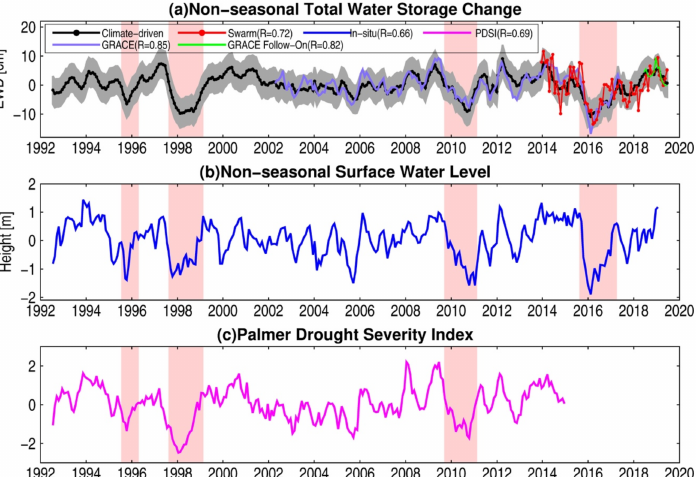
Figure 5. ( a ) Nonseasonal signals of the climate-driven, GRACE, GFO, and Swarm TWSC, ( b ) non- seasonal surface water level, and ( c ) basin-averaged Palmer Drought Severity Index (PDSI) in the Amazon basin. The red areas represent drought periods identified from the climate-driven TWSC time series. The 95% confidence interval for the nonseasonal climate-driven TWSC is drawn in Figure 5a. EWD, equivalent water